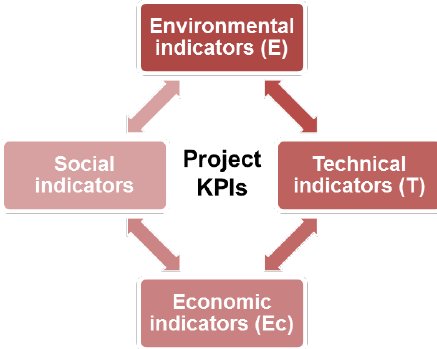
Figure 6. Areas of evaluation of measures and scenarios through Project Level Indicators.